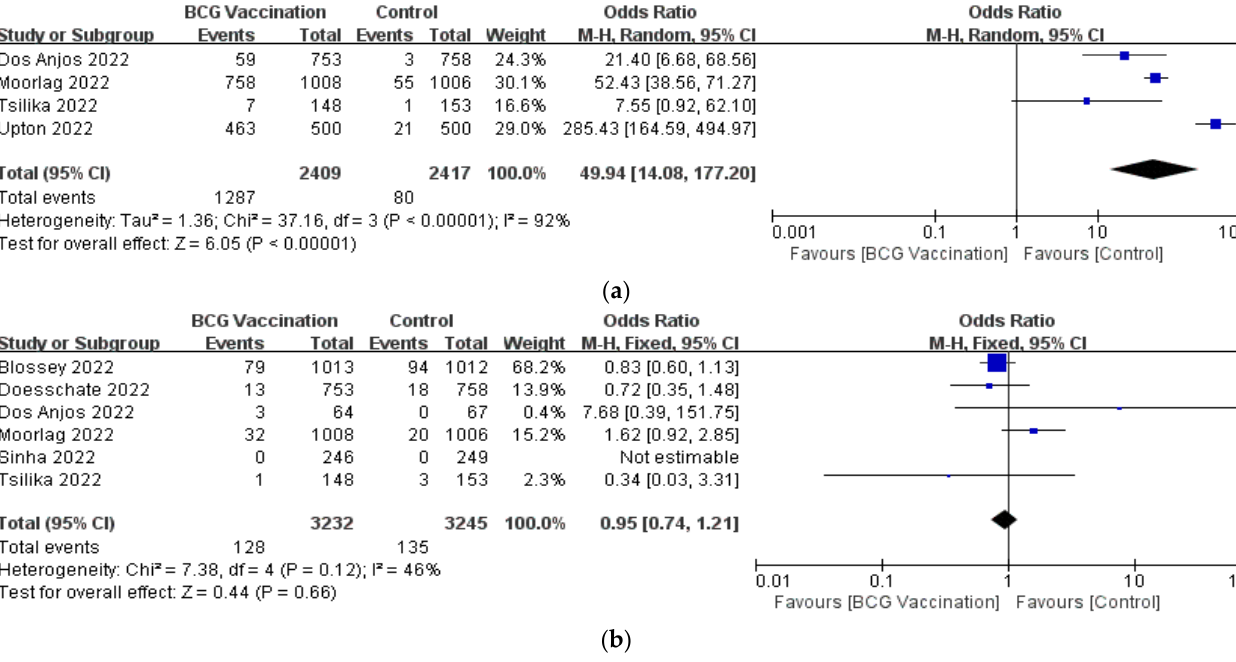
Figure 5. Forrest plot of the odds ratio of the ( a ) local injection response ; ( b ) serious AEs between the BCG vaccination group and the control group.